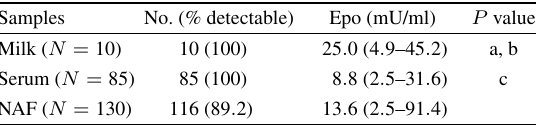
Median of EPO levels in milk, serum and nipple aspirate fluid samples Samples